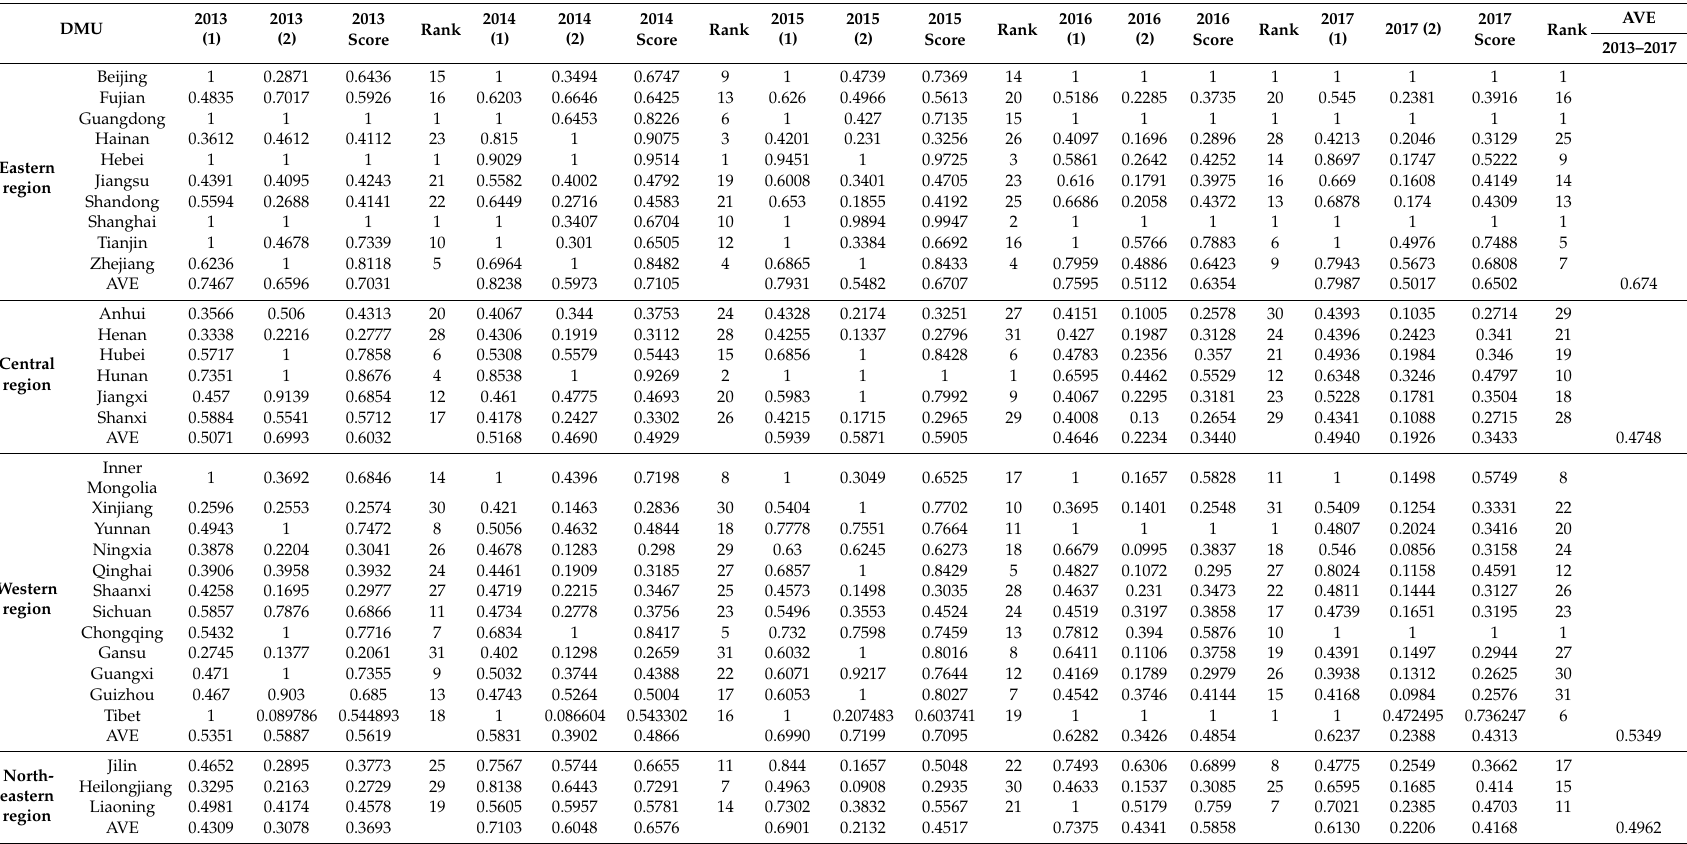
Table 3. Total e ffi ciency scores and ranks of provinces, municipalities, and autonomous regions from 2013 to